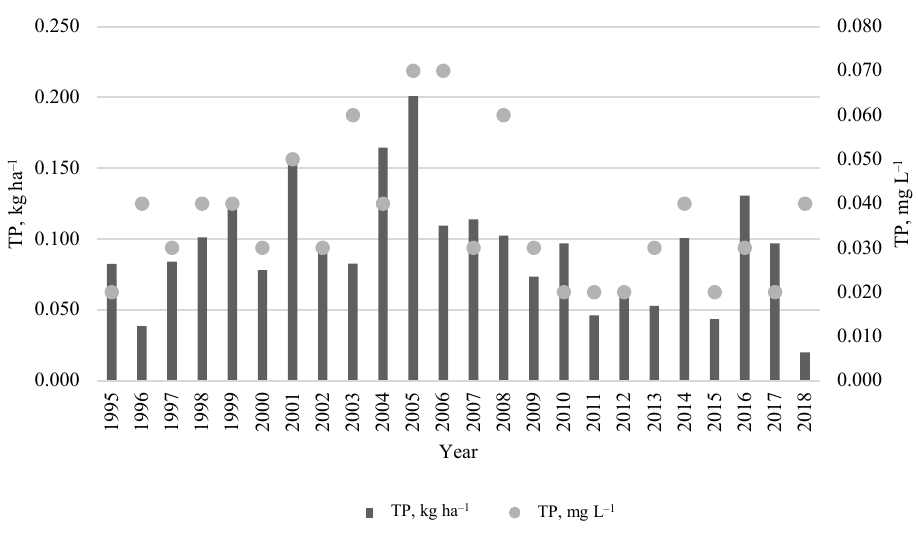
Fig. 6. Annual losses (kg ha –1 ) and concentrations (mg L –1 ) of total phosphorus (TP) in the Vienziemite subsurface drainage field.